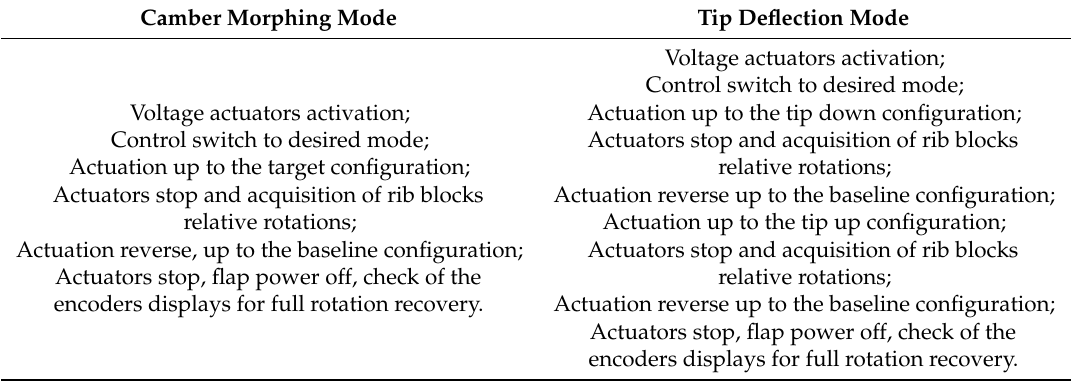
Figure 14. Flap configurations functionality test.